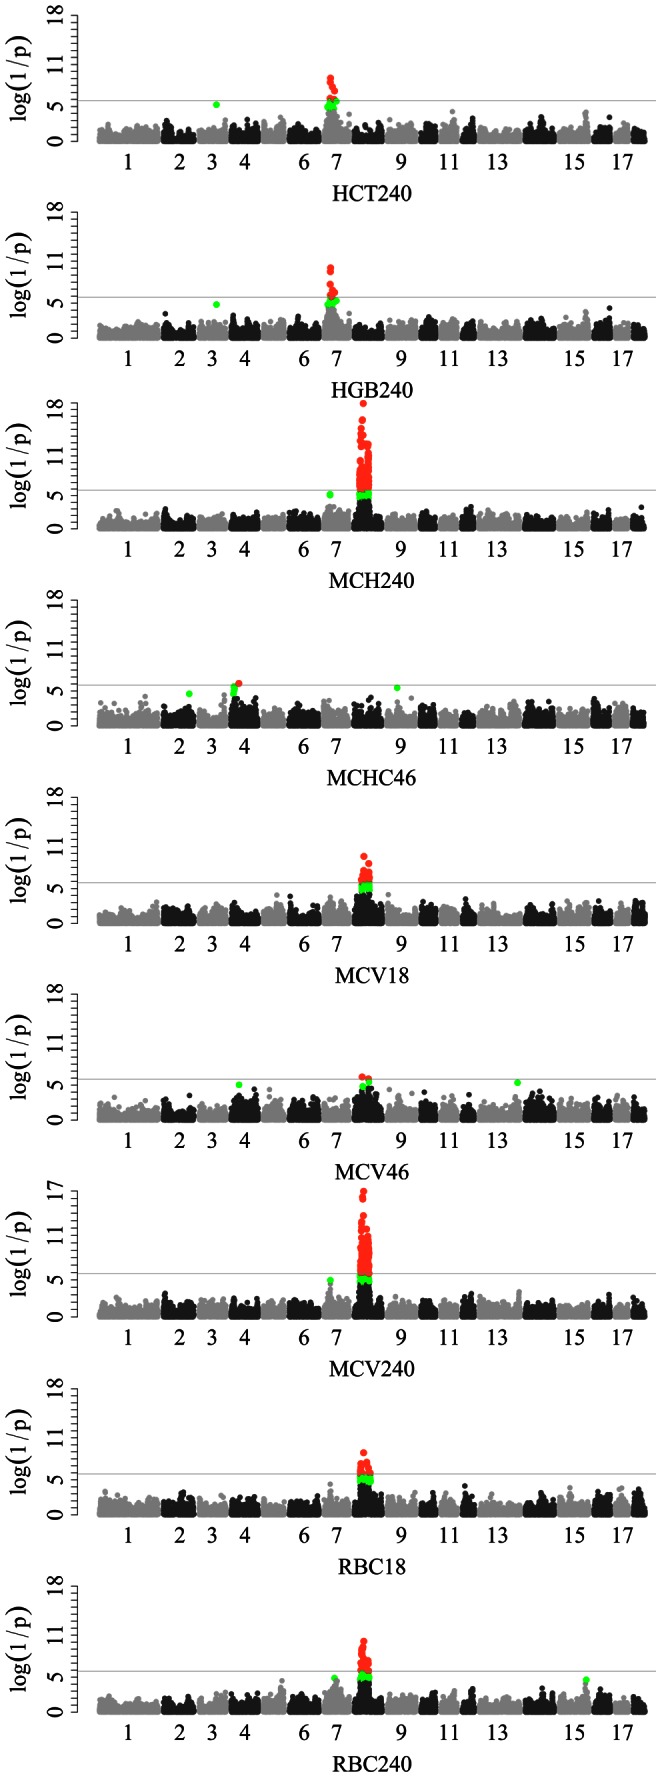
Manhattan plots for the single-marker analysis of erythrocyte traitslog10(1/p) values are shown for all SNPs that passed quality control. The dotted line denotes the Bonferroni-corrected genome-wide significant threshold. SNPs surpassing the genome-wide threshold are highlighted in pink and SNPs reaching the suggestive threshold in green. HCT240: hematocrit at 240 days; HGB240: hemoglobin at 240 days; MCH240: mean corpuscular hemoglobin at 240 days; MCHC46: mean corpuscular hemoglobin content at 46 days; MCV18, MCV46, MCV240: mean corpuscular volume at 18, 46 and 240 days; RBC18 and RBC240: red blood cell count and at 240 days.